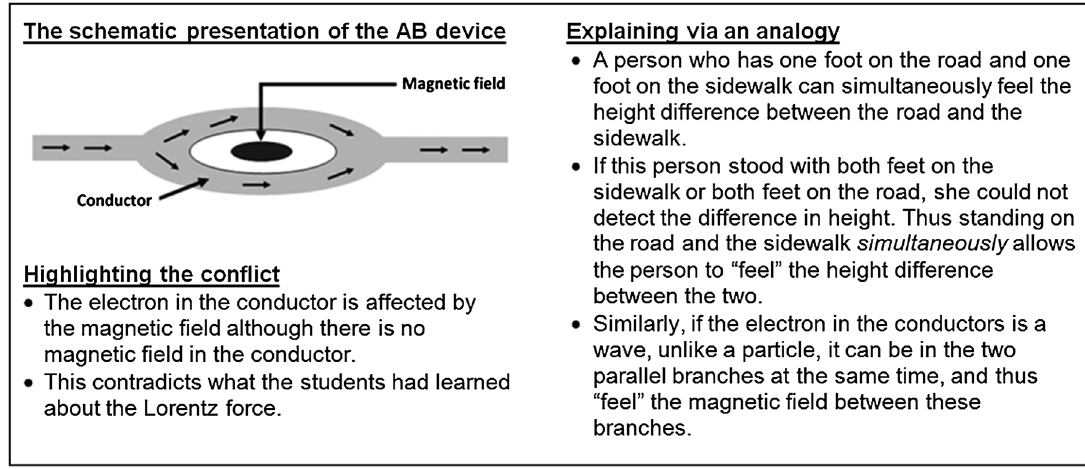
FIG. 1. A person-electron analogy of the AB